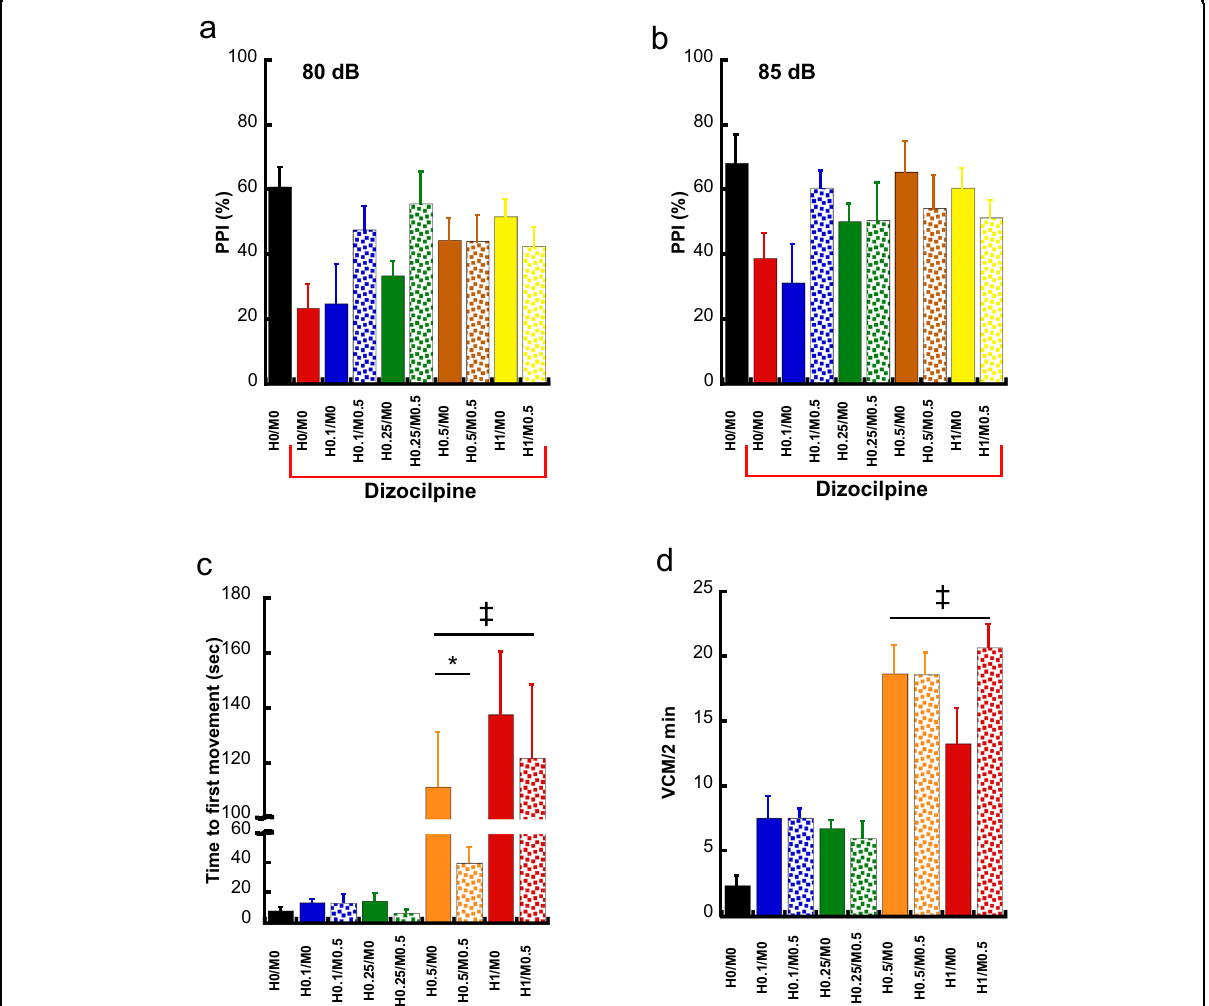
Fig. 3 Results of the behavioral tests. The effect of the various haloperidol and MDL-100,907 combinations on the disruption of the PPI by dizocilpine using a ( a ) 80 dB and a ( b ) 85 dB auditory pulse (mean± SEM values). The leftmost bar corresponds to the control group (H0/M0), not pre-treated with dizocilpine (baseline PPI). The rest correspond to rats pretreated with dizocilpine. The haloperidol and MDL-100,907 dosages are depicted below each bar. No signi fi cant differences were found in pairwise comparisons. c Results of the catalepsy tests under the various chronic treatment combinations (mean±SEM). ‡ Denotes signi fi cant differences between the mean time lapses between these four doses compared to the control (H0M0). *Denotes a signi fi cant difference between the H0.5M0 and the H0.5/M0.5 group. d The effect of the chronic treatment with haloperidol and MDL-100,907 on the induction of VCM/2min (mean±SEM). ‡ Denotes a signi fi cant increase in the number of the VCM compared to vehicle-treated